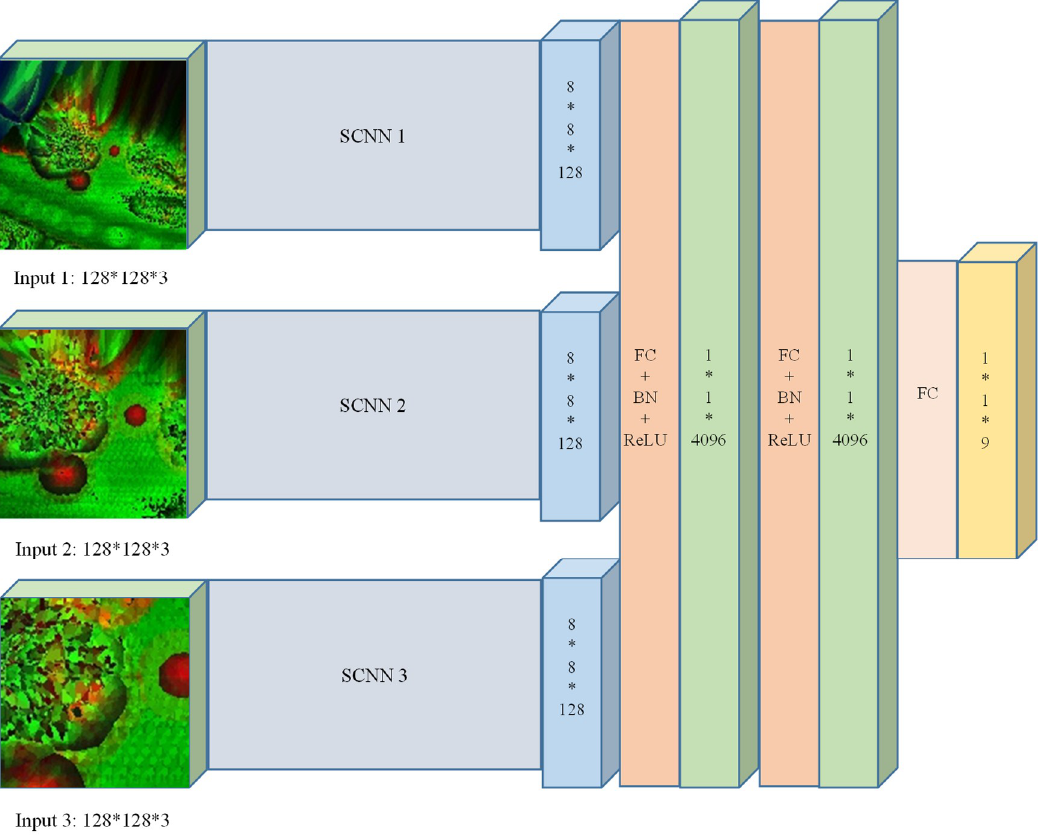
Figure 4. The architecture of the MCNN.